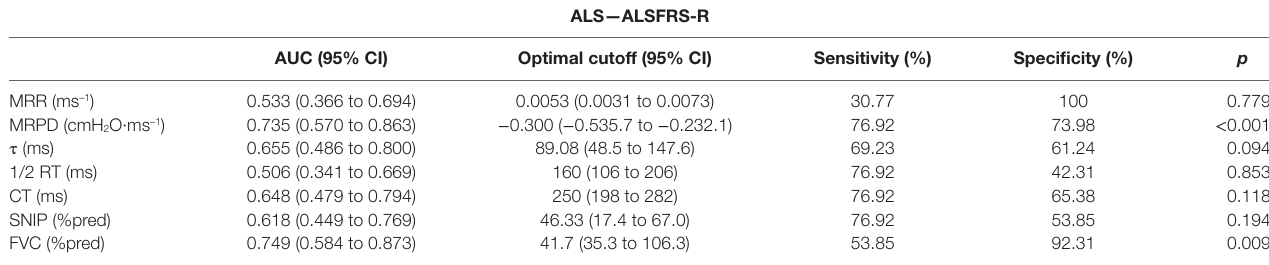
TaBle 4 | Receiver operating characteristic analysis between ALS subjects classified according to a decrease in the ALSFRS-R scale score.